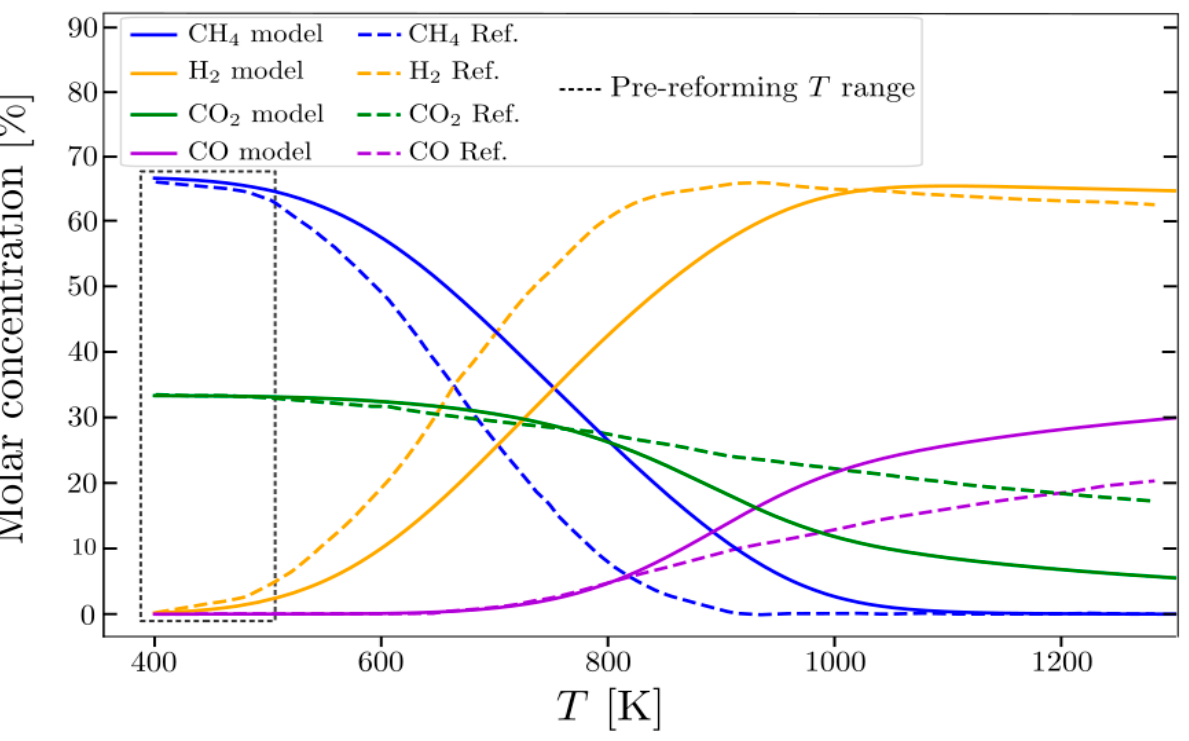
Figure 3. Ethylene glycol reforming: comparison between the results of the implemented model Figure 4. Acetone reforming: comparison between the results of the implemented model (solid) and (solid) and the results reported in the results reported in [39].